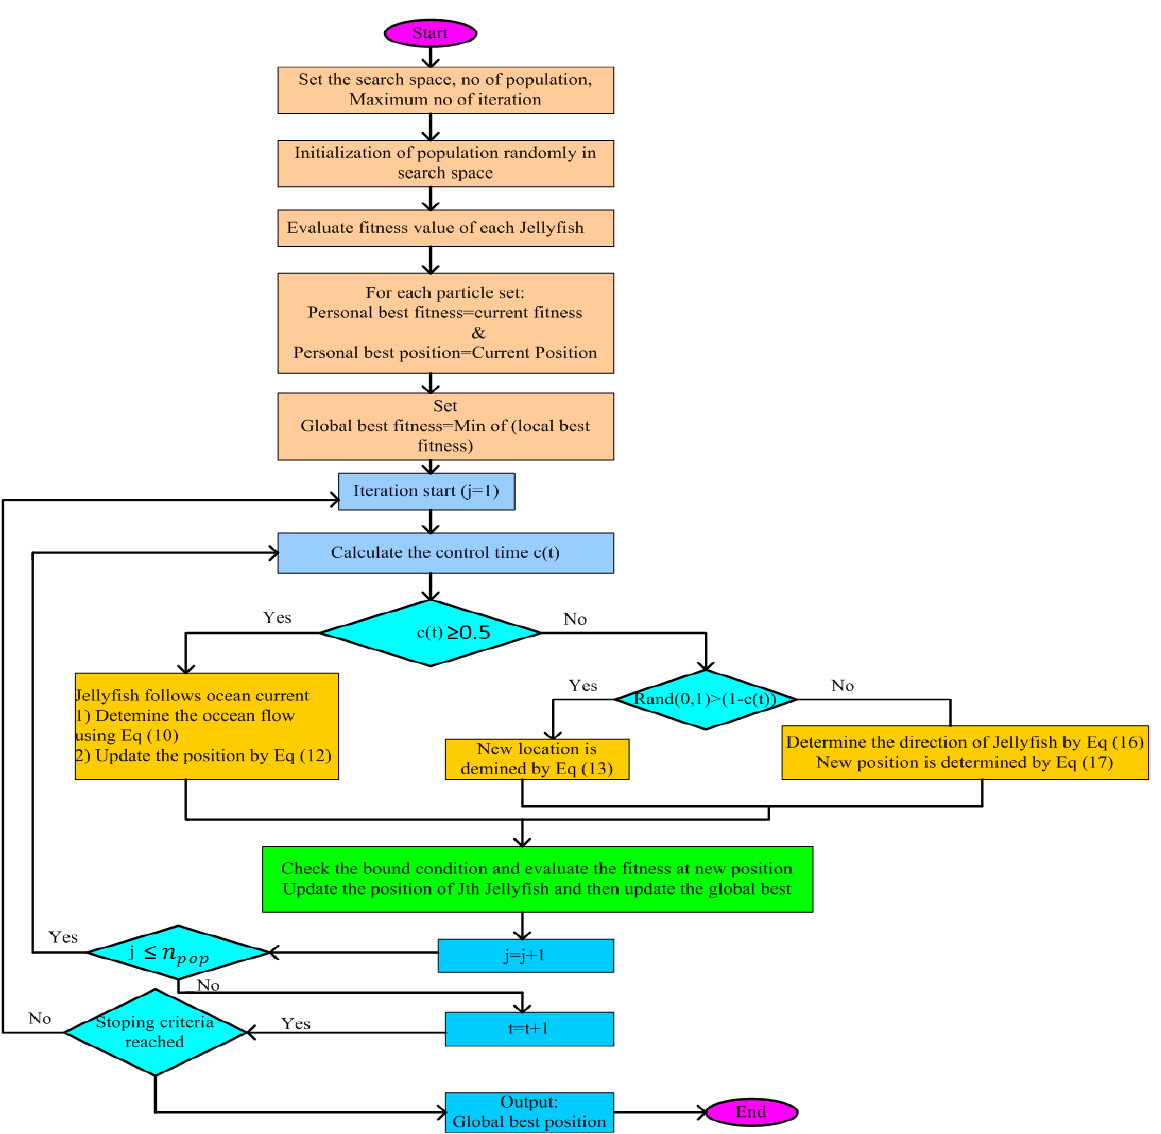
Figure 4. The Schematic flow chart for JSO.